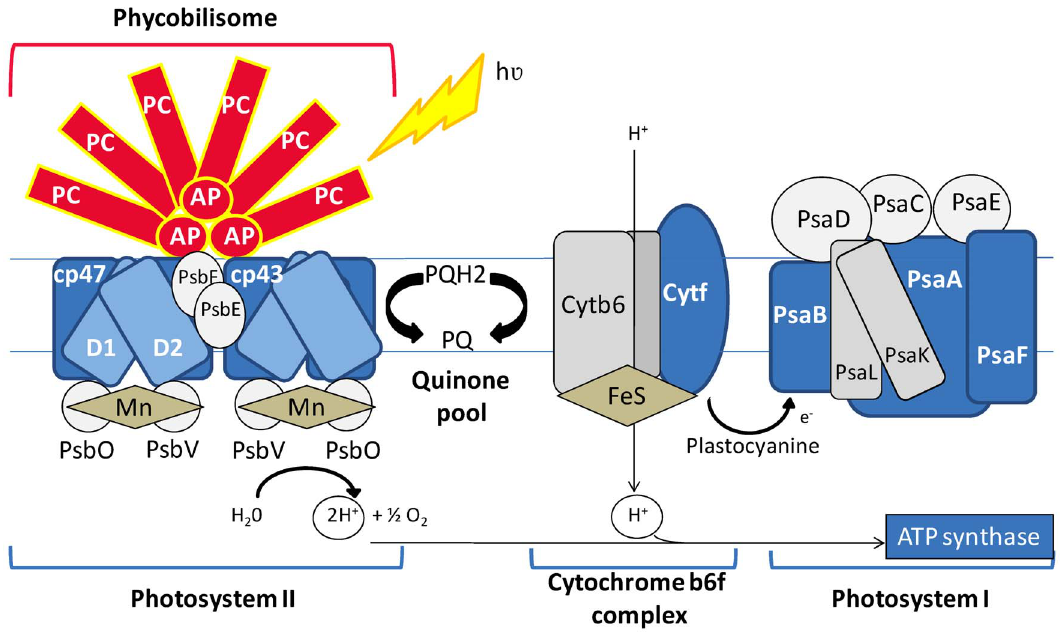
Figure 5. Cartoon depicting proteins associated with photosynthesis that are differentially regulated under the LD cycle. Each protein of the diagram is colored based on increased (red) or decreased abundance (blue) relative to the dark growth phase. Proteins colored in grey were not quantified.